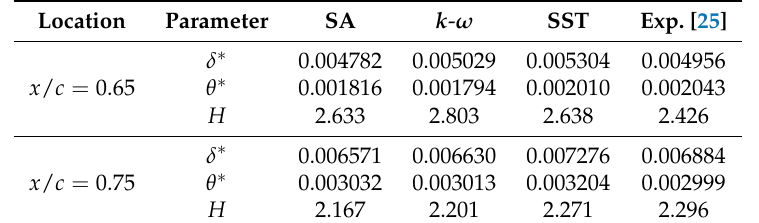
Table 2. Boundary layer parameters at x / c = 0.65 and 0.75 in the RAE2822 airfoil.